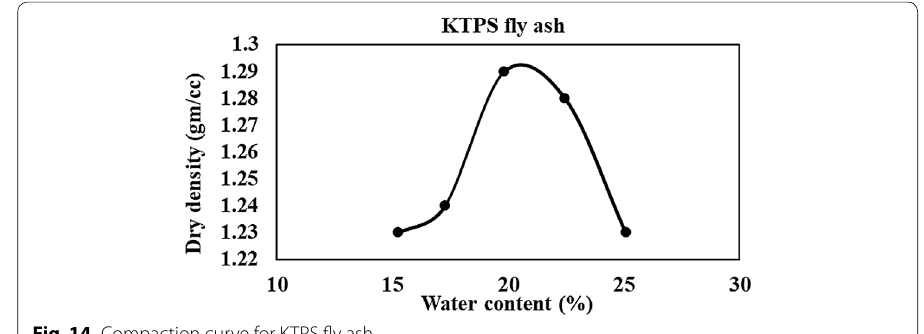
Fig. 14 Compaction curve for KTPS fly ash